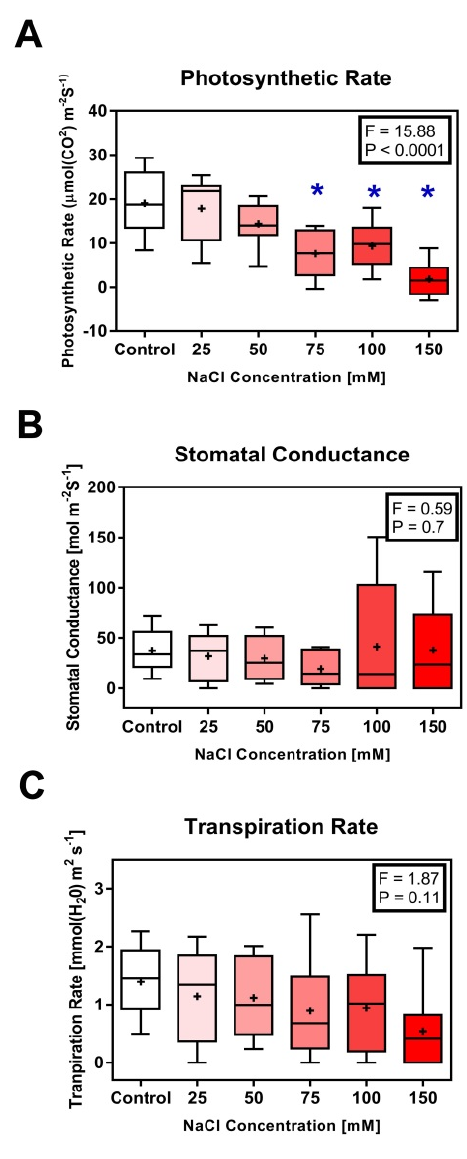
Figure 3. Side-by-side boxplots of changes in photosynthetic parameters in Solanum melongena . ( A ) Photosynthesis rate ( P N ) [ µ mol m –2 s –1 ], ( B ) stomatal conductance ( g s ) [mol H 2 Om –2 s –1 ]; ( C ) transpiration rate ( E ) [mmol H 2 O m –2 s –1 ]; in response to each of five NaCl concentrations. p -values at α = 0.05. * indicates values significantly different from the control (Dunnett’s test with p < 0.05).